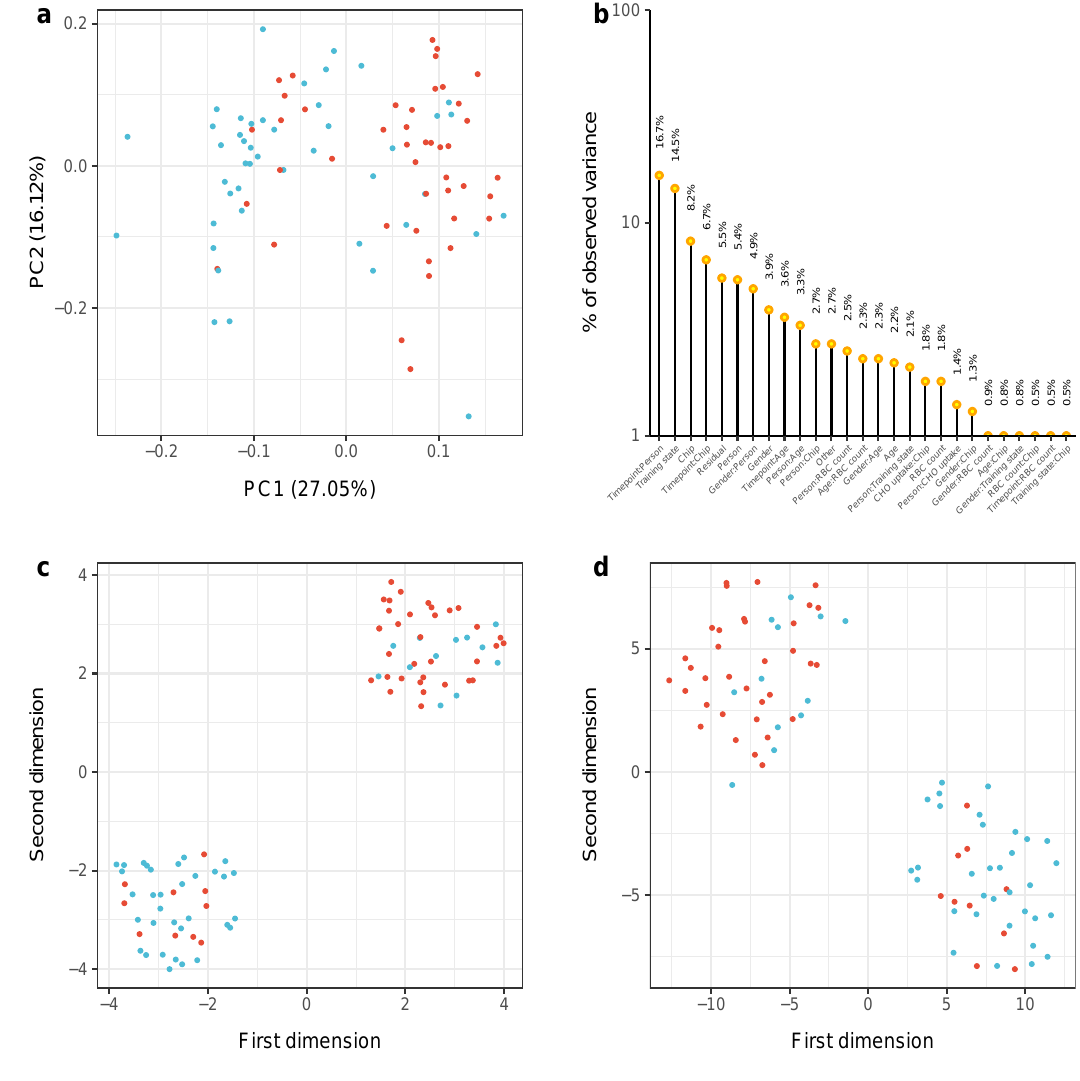
Figure 2. Analysis of variance and factors explaining it using measured miRNA expression data. ( a ) Sample distribution within the first two principal components obtained from principal component analysis (PCA) along with the percentage of variance explained in each dimension; ( b ) Results from principal variance component analysis (PVCA) showing estimates of variance in the expression data that can be explained with both known and unknown (hidden) sample annotation factors. Each bar corresponds to one factor, where mixed interactions between two variables are also possible and marked respectively by a colon; ( c ) two-dimensional uniform manifold approximation and projection (UMAP) embedding using the miRNA-sample matrix X ∈ R 90 × 307 ; ( d ) two-dimensional t-distributed stochastic neighbor embedding (t-SNE) embedding using the miRNA-sample matrix X . In each dimension reduction panel a single point corresponds to one sample that is colored according to the timepoint of blood extraction and relative to the training period, i.e., before (blue) or after (red) one of the training